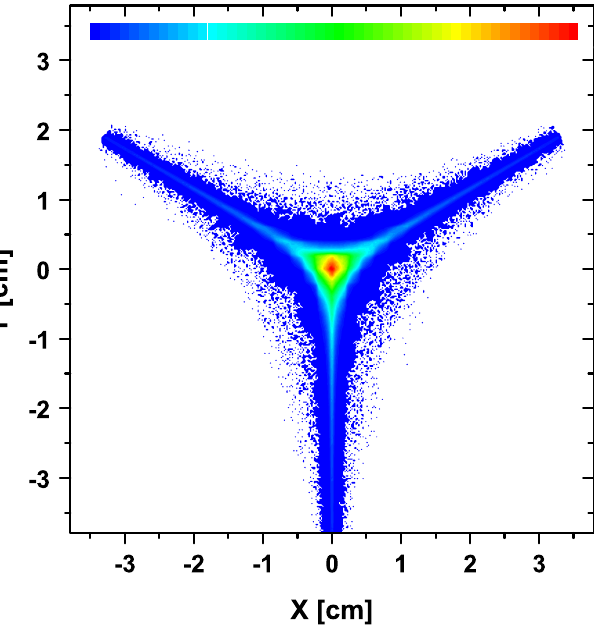
FIG. 6. (Color) Spatial distribution of the lost neon ions at the plasma electrode.